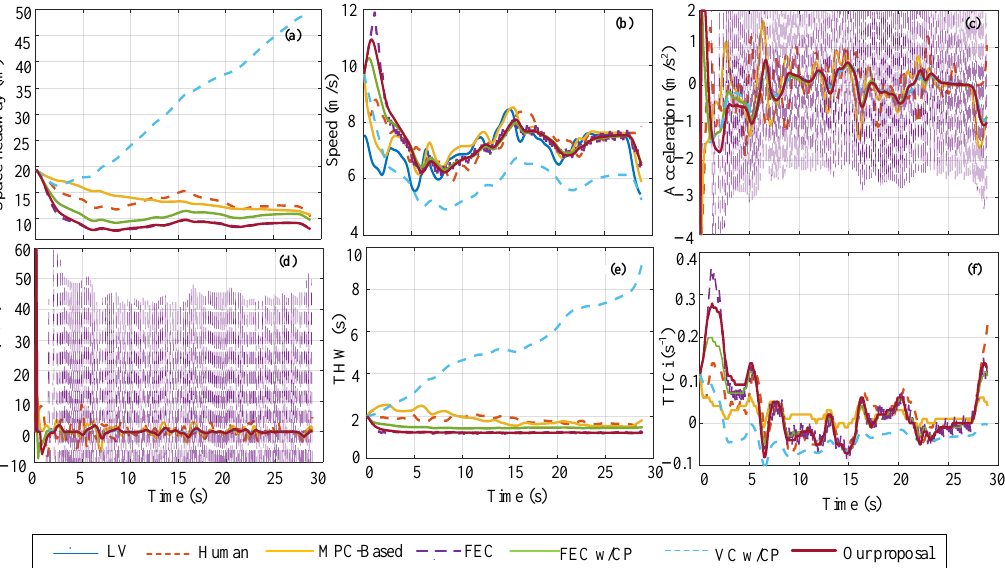
Figure 10. Comparison of decision performance of different strategies in single-scenario training dataset, where ( a – f ) correspond to space headway, speed, acceleration, jerk, THW, and TTCi, re- spectively.